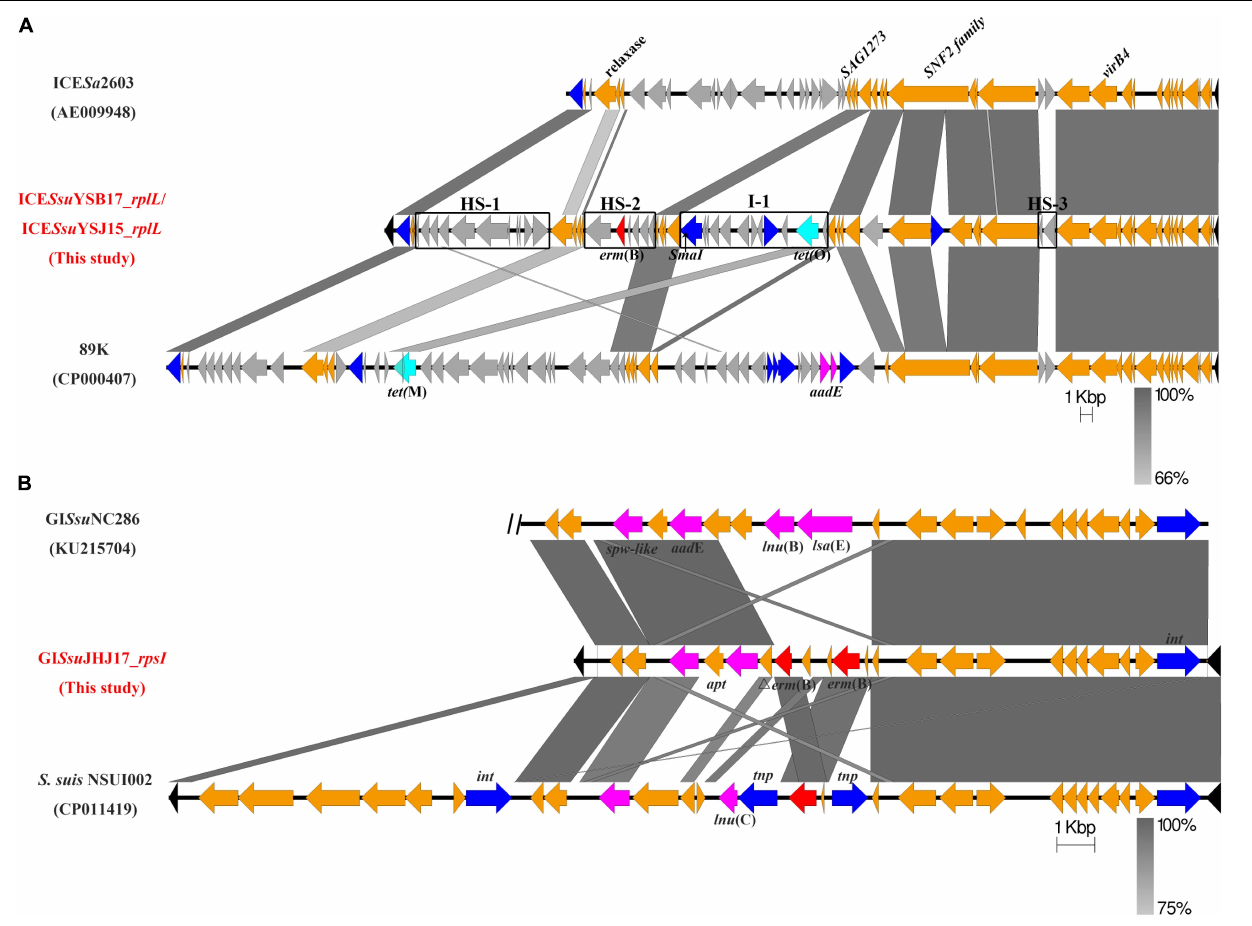
FIGURE 1 | Genetic features of the mobile genetic elements ICE Ssu YSB17_ rplL and GI Ssu JHJ17_ rpsI . The direction of the arrow indicates the direction of transcription. Homologous regions are shaded in gray. Genes are shown in different colors: the ICE and GI flanking chromosomal genes were shown in black, the 30 conserved core genes of the ICE Sa 2603 family backbone and GI Ssu JHJ17_ rpsI backbone are in orange, and variable genes are in light gray. Integrase/transposase/recombinase genes were highlighted in blue, erm (B) is marked in red, tet-resistant genes are in pale blue, and other resistant genes are labeled in pink. (A) Comparison of ICE Ssu YSB17_ rplL /ICE Ssu YSJ15_ rplL with ICE Sa 2603 and 89K. Intergenic hotspots HS-1, HS-2, and HS-3 and insertion site I-2 were indicated. Sma I restriction site is marked by a black arrow. (B) GI Ssu JHJ17_ rpsI from S. suis JHJ17 and linear DNA comparison against part of ICE Ssu NC286 and fragments of S. suis NSUI002. The two vertical black diagonal lines on the left of NC286 indicate that there is still a part of the sequence that is not